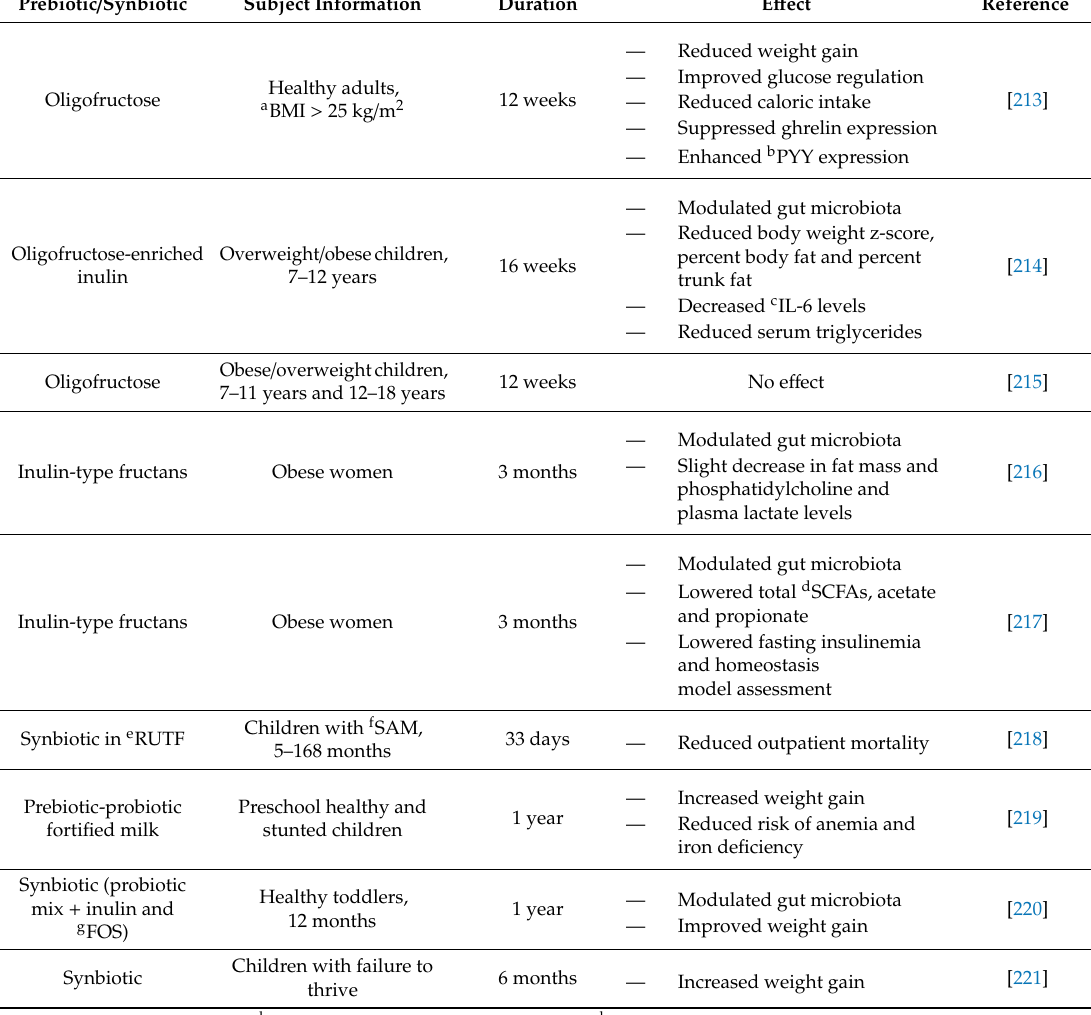
Table 3. Impact of prebiotics and synbiotics on overnutrition and undernutrition in human intervention studies. Prebiotic /